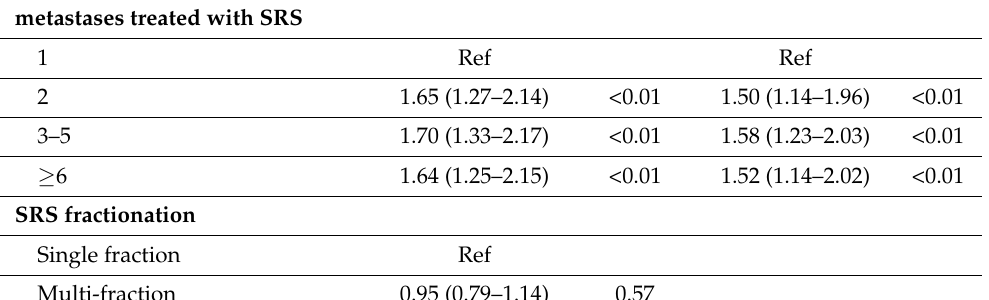
Univariate Analysis Multivariate